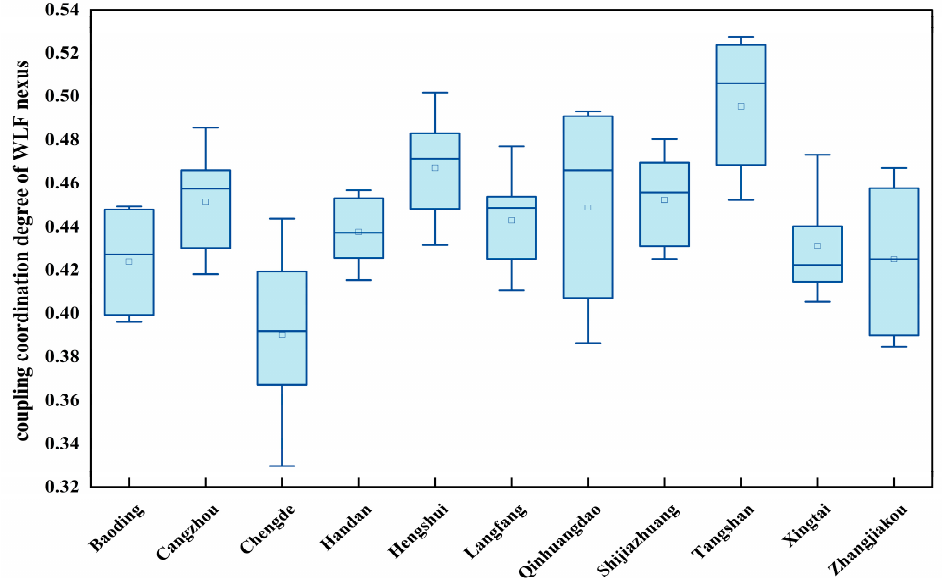
Figure 4. The degree of coupling coordination of the WLF nexus system in 11 cities of Hebei Province.